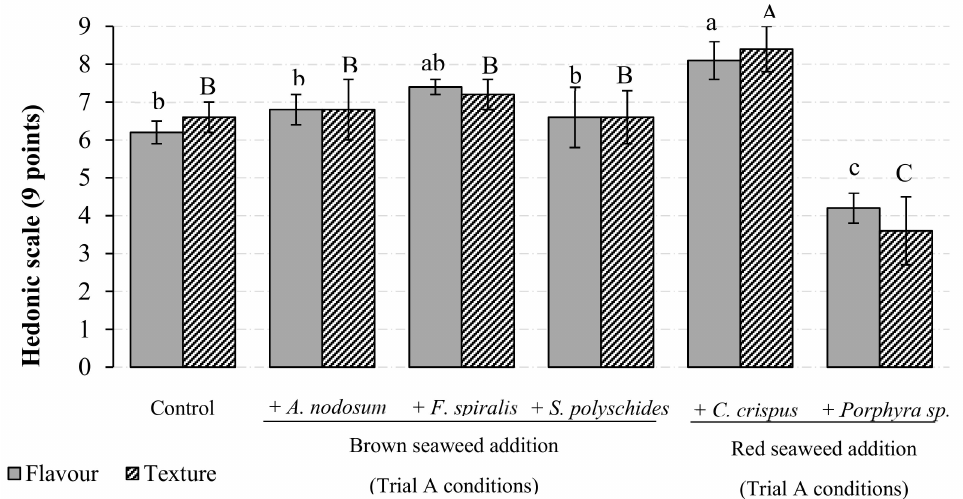
Figure 1. Sensory evaluation of flavour and texture (mean ± SD) of the canned mackerel produced by the traditional process (Control) and under the Trial A conditions with the incorporation of brown ( A. nodosum , F. spiralis , S. polyschides ) and red ( C. crispus , Porphyra sp.) seaweed species. Attributes were evaluated by fifteen individuals using a hedonic scale (nine points), which ranged from “one—dislike extremely” to “nine—like extremely”. Bars labelled with di ff erent subscript (a–c) and superscript (A–C) letters have, respectively, mean values of flavour and texture significantly di ff erent at p < 0.05 (Tukey’s post hoc